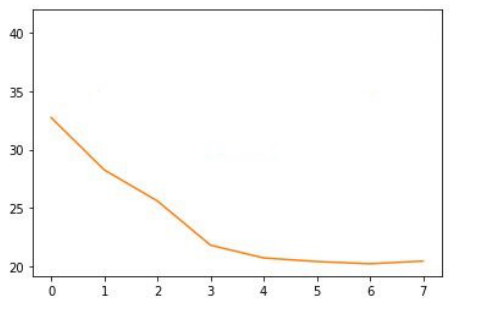
Figure 9. Regression Loss of our proposed model EfficientNet B3 with parallel convolutions (Center-